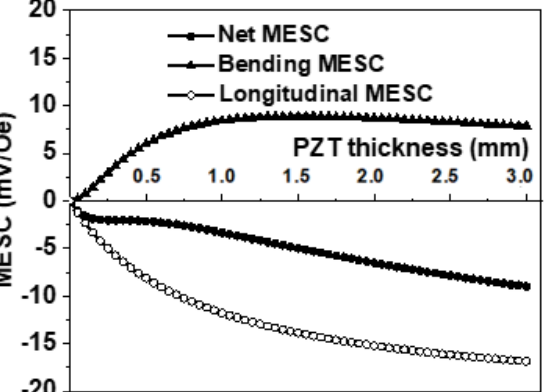
Figure 6. Results on estimated MEVC vs. t m , as in Figure 2 for a bilayer of Metglas and PZT for t p = 0.5 mm.